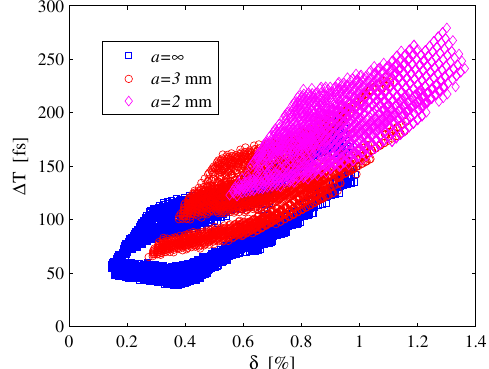
FIG. 10. Working points for different a of the wakefield structure. The peak current requirement is 3 – 5 kA of the core beam.